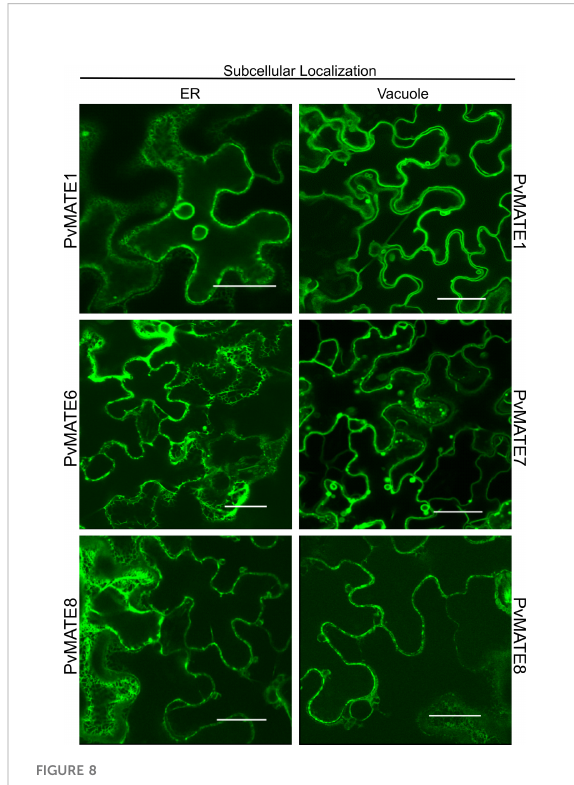
FIGURE 8 Subcellular localization of four selected PvMATE candidates. Each PvMATE was translationally fused upstream of the YFP reporter gene (visualized in green), co-transformed with A. tumefacians containing plasmids with organelle marker into N. benthamiana via A. tumefacians , and visualized in leaf epithelial cells by confocal microscopy. Merged signals are shown in Supplementary Figure S5. Scale: